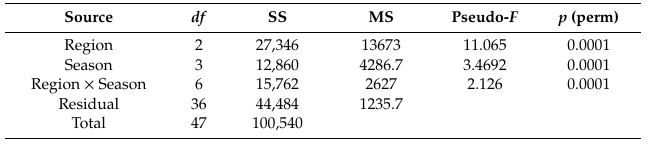
Table 4. PERMANOVA analysis of macroinvertebrate communities in the Weishan Lake.